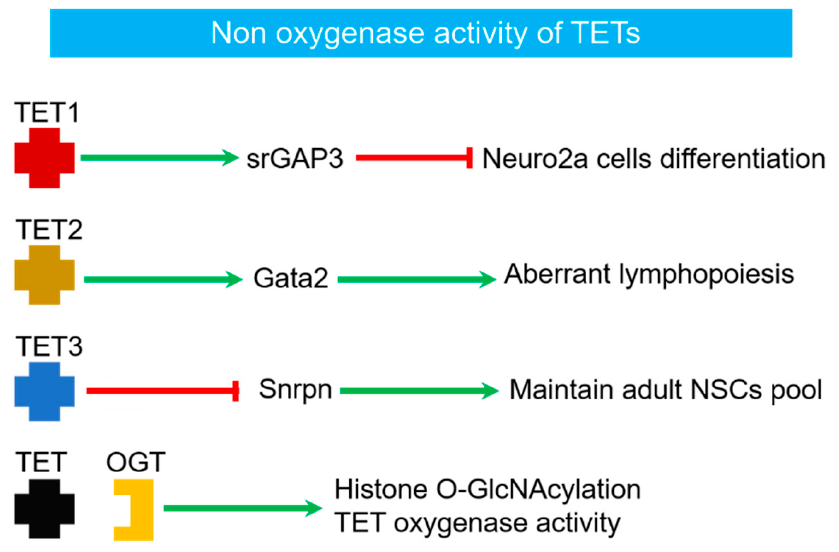
Figure 2. Examples of Non oxygenase activity of TET proteins.